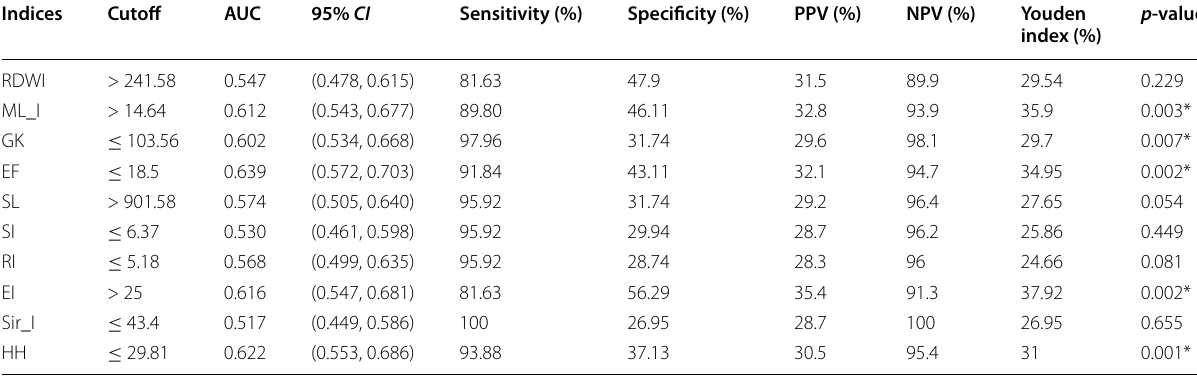
*Statistically significant at